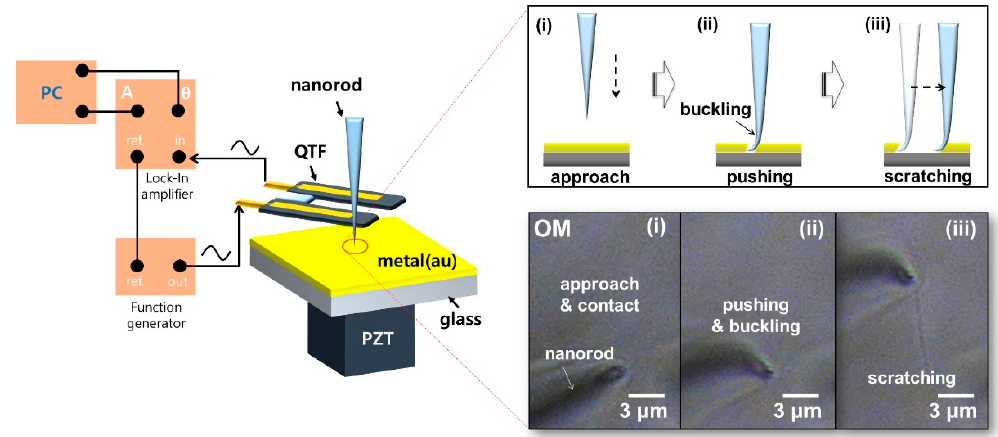
Figure 6. Nanoscratching via nanorod / QTF–AFM. The experimental procedure was as follows: (i) contact, (ii) buckling, and (iii) nanoscratching. After the buckled tip was ready by pushing, we started the lateral motion to perform nanoscratching. The OM located under the interest substrate was used to observe nanoscratching phenomena.